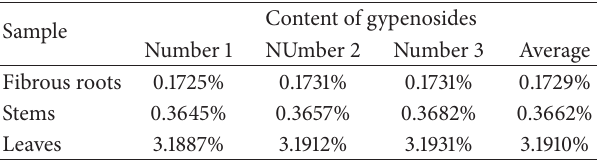
Table 5: Content distribution of gypenosides in G. pentaphyllum